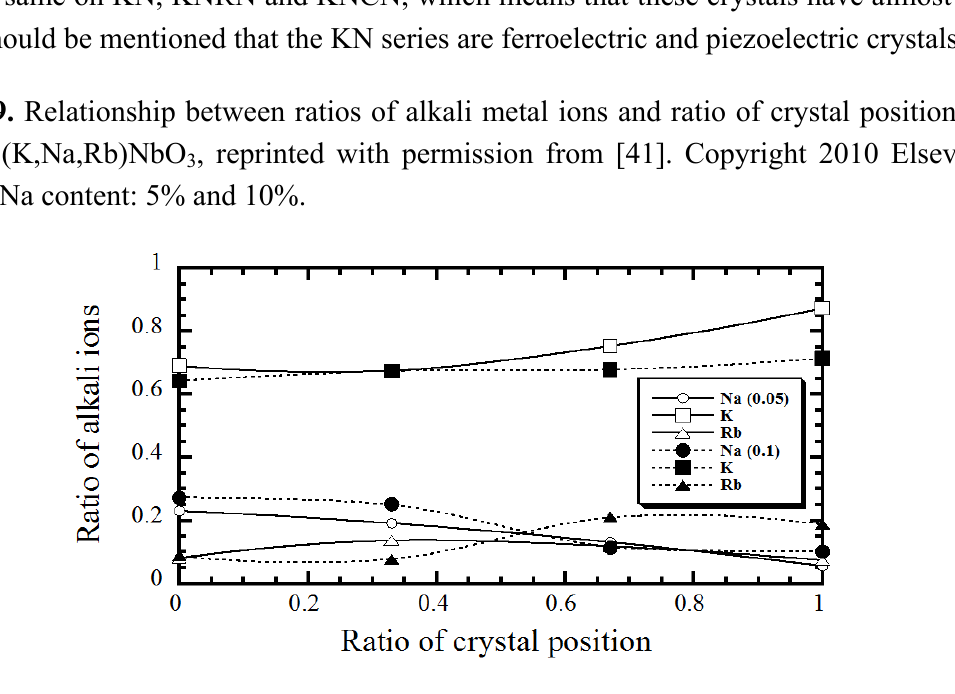
, KNN: (K,Na)NbO , KNRN: 3 3 , reprinted with permission from [45]. Copyright 3